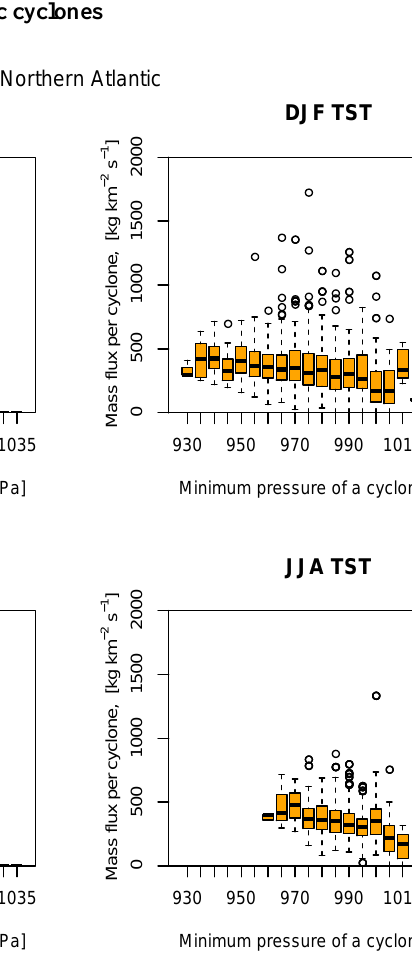
becomes most pronounced in the decaying phase (right